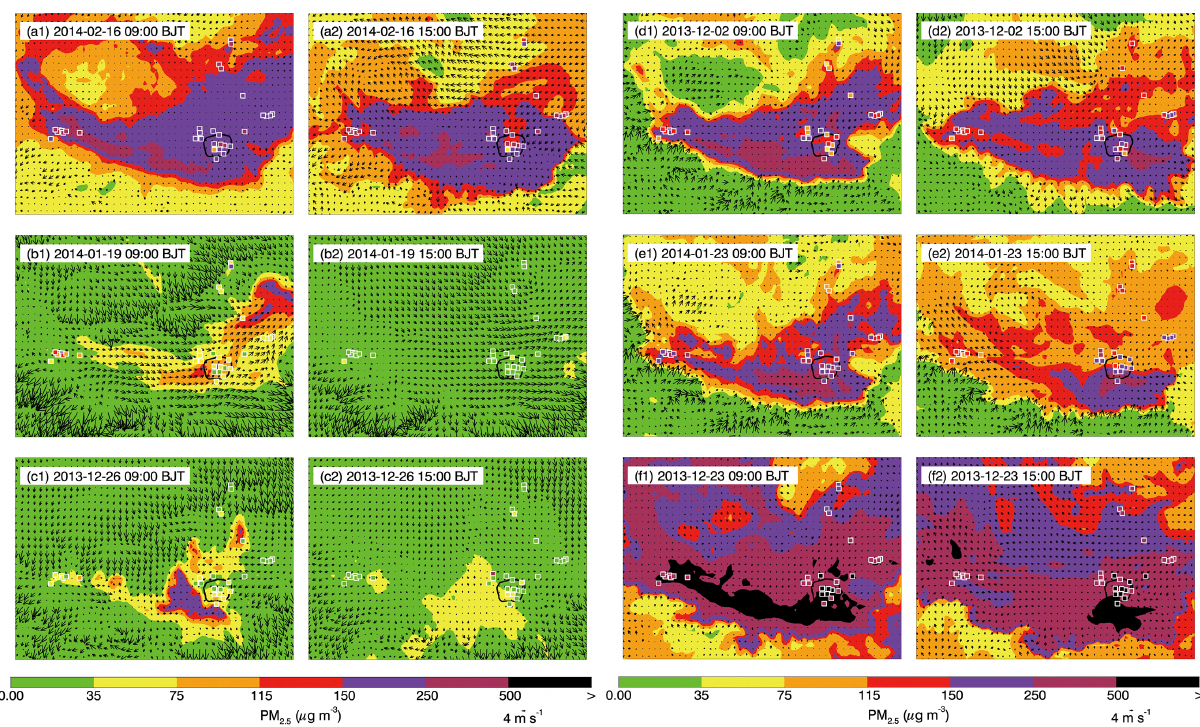
Figure 9. Pattern comparison of simulated vs. observed near-surface PM 2 . 5 mass concentrations at 09:00 and 15:00BJT on (a) 16 February 2014 (“north-low”), (b) 19 January 2014 (“southwest-trough”), (c) 26 December 2013 (“southeast-high”), (d) 2 December 2013 (“transi- tion”), (e) 23 January 2014 (“southeast-trough”), and (f) 23 December 2013 (“inland-high”). Colored squares: PM 2 . 5 observations; color contour: PM 2 . 5 simulations; black arrows: simulated surface winds.